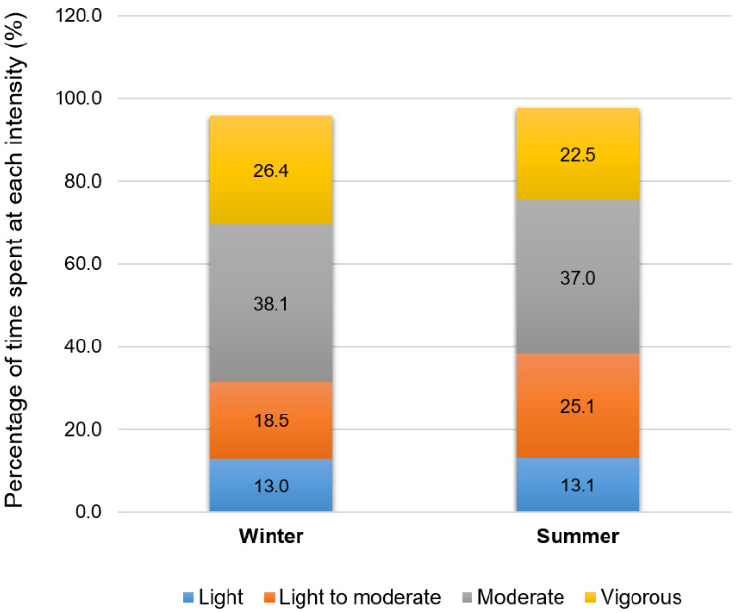
Figure 2. Time spent at light, light to moderate, moderate, or vigorous intensities during the Aqua walking training session performed either during wintertime or summertime.